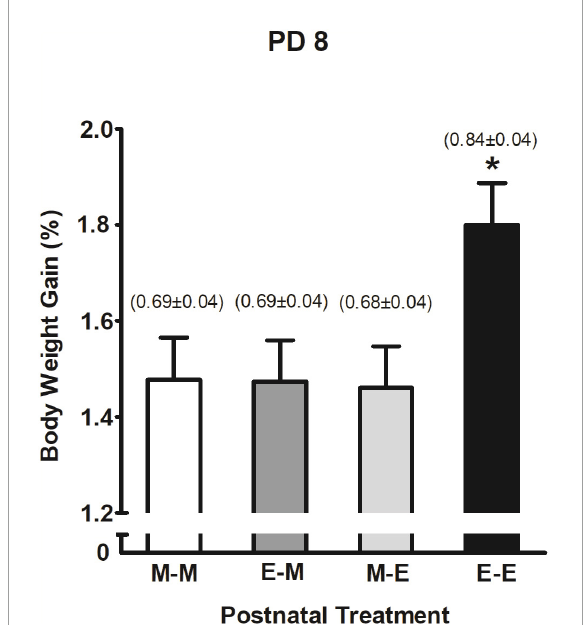
FIGURE7 Percent body weight gain as a function of postnatal treatment at PD 8. * p < 0.05 indicates pups that received ethanol as the sole liquid (E-E) are different from all groups. Numbers in brackets indicate ethanol intake (g/kg) at PD 8 (mean ± SEM). Vertical lines illustrate standard errors of the mean